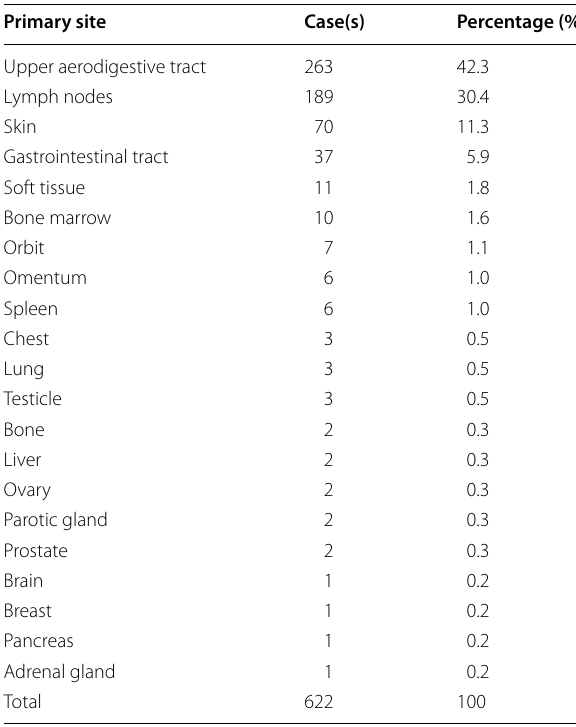
Table 4 Clinical features of 91 patients with extranodal natural killer (NK)/T-cell lymphoma, nasal